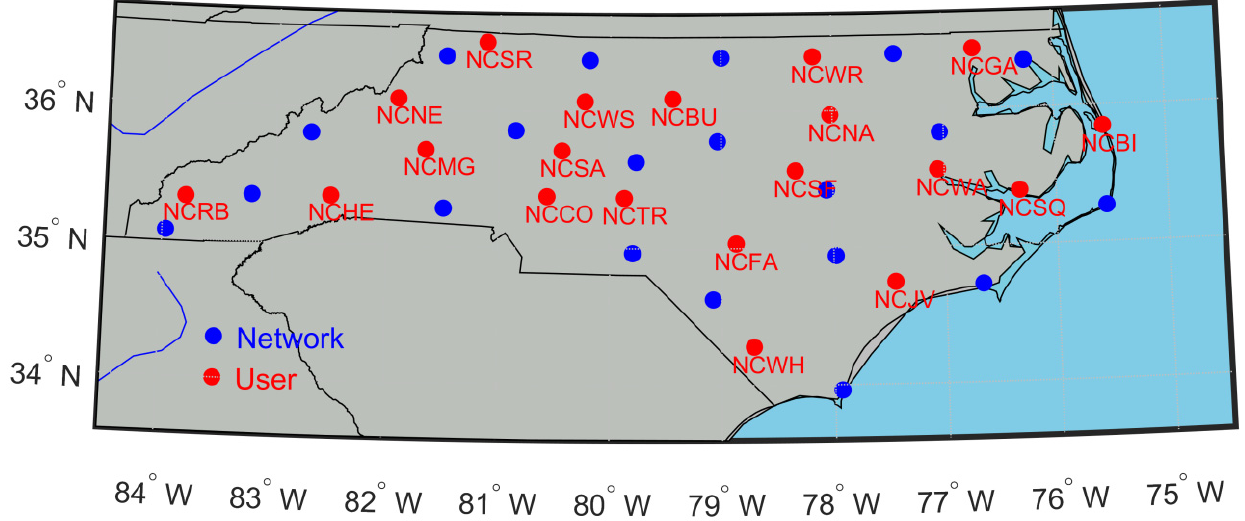
Figure 1. GNSS network of North Carolina. Blue points represent the reference station, while red points represent the user stations. Table 1. Summary of the strategy of data processing for data processing.